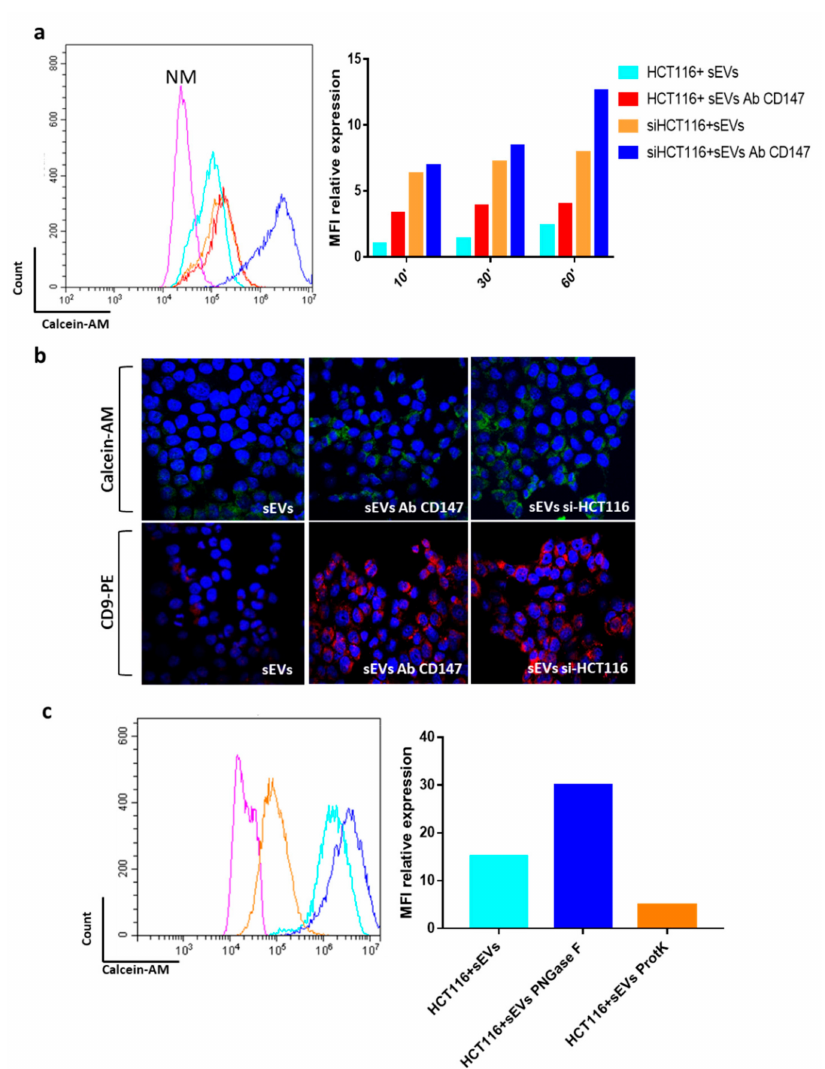
Figure 9. Blocking CD147 ON sEVs increases their cellular internalization. ( a ) Analysis of sEVs (small extracellular vesicles) uptake in recipient HCT116 and in CD147 knockdown HCT116 cells (siHCT116) compared to the uptake of sEVs blocked with CD147 antibody (sEVs CD147); data representative of three independent experiments are shown by bar charts on the right; ( b ) qualitative confirmation of Calcein-AM or anti-CD9 antibodies stained sEVs uptake in control HCT116 and in CD147 knockdown HCT116 cells (si-HCT116) by confocal microscopy. DAPI (blue) = staining nuclei; Calcein-AM = green; CD9-PE = red. ( c ) Same experiment as described in ( a ) using sEVs pretreated with proteinase K (ProtK) or N-Glycosidase F (PNGase F). Representative examples of staining after 1hours of incubation with CR-CSC–released sEVs. The images are representative of three independent experiments. NM = HCT116 treated for 1 h with Re121-sEVs not-stained with 1 µ M Calcein-AM; HCT116 sEVs = HCT116 recipient cells treated for 1 h with sEVs stained with 1 µ M Calcein-AM; siHCT116 + sEVs = HCT116 recipient cells transfected with non-targeting control and treated for 1 h with Re121 sEVs stained with 1 µ M Calcein-AM; HCT116 + sEVs Ab CD147 = HCT116 cells treated with Re121 sEVs CD147 blocked with antibody. Magnification = 600 ×